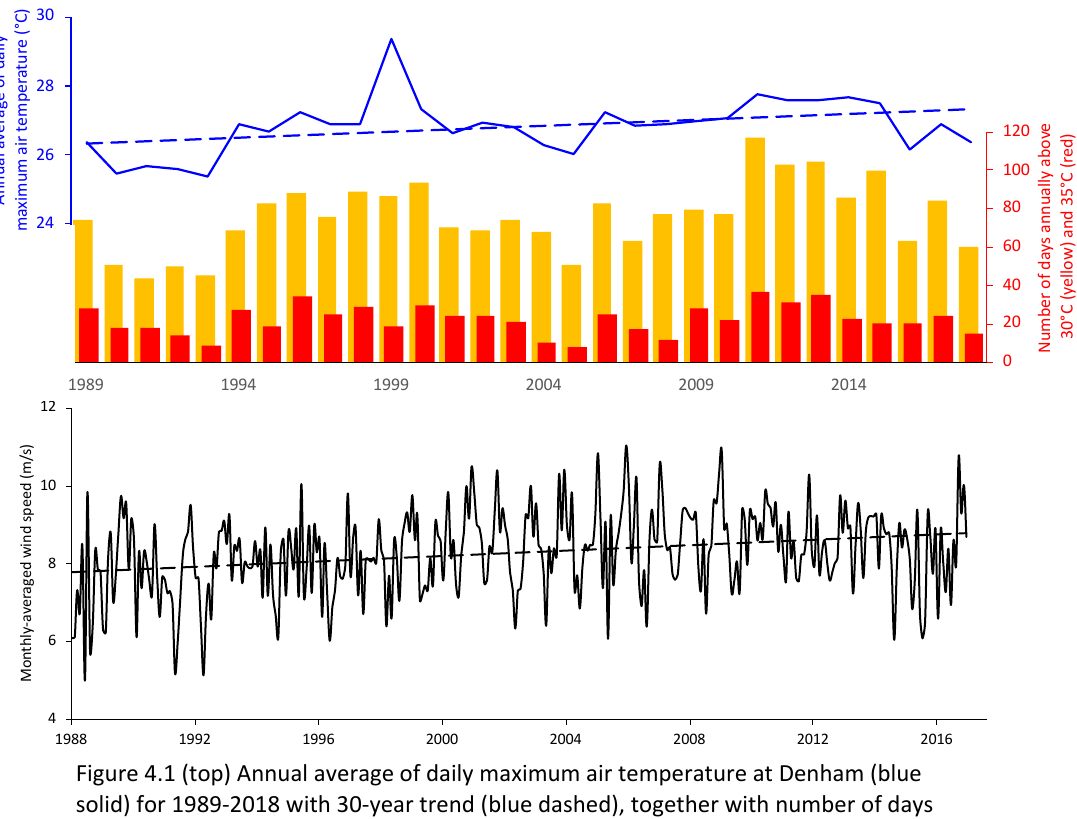
Figure 4.1 (top) Annual average of daily maximum air temperature at Denham (blue solid) for 1989-2018 with 30-year trend (blue dashed), together with number of days exceeding 30 ° C (yellow bars) and 35 ° C (red bars). (bottom) Monthly-averaged wind speed in the north of Shark Bay for 1988-2016 with 29-year trend